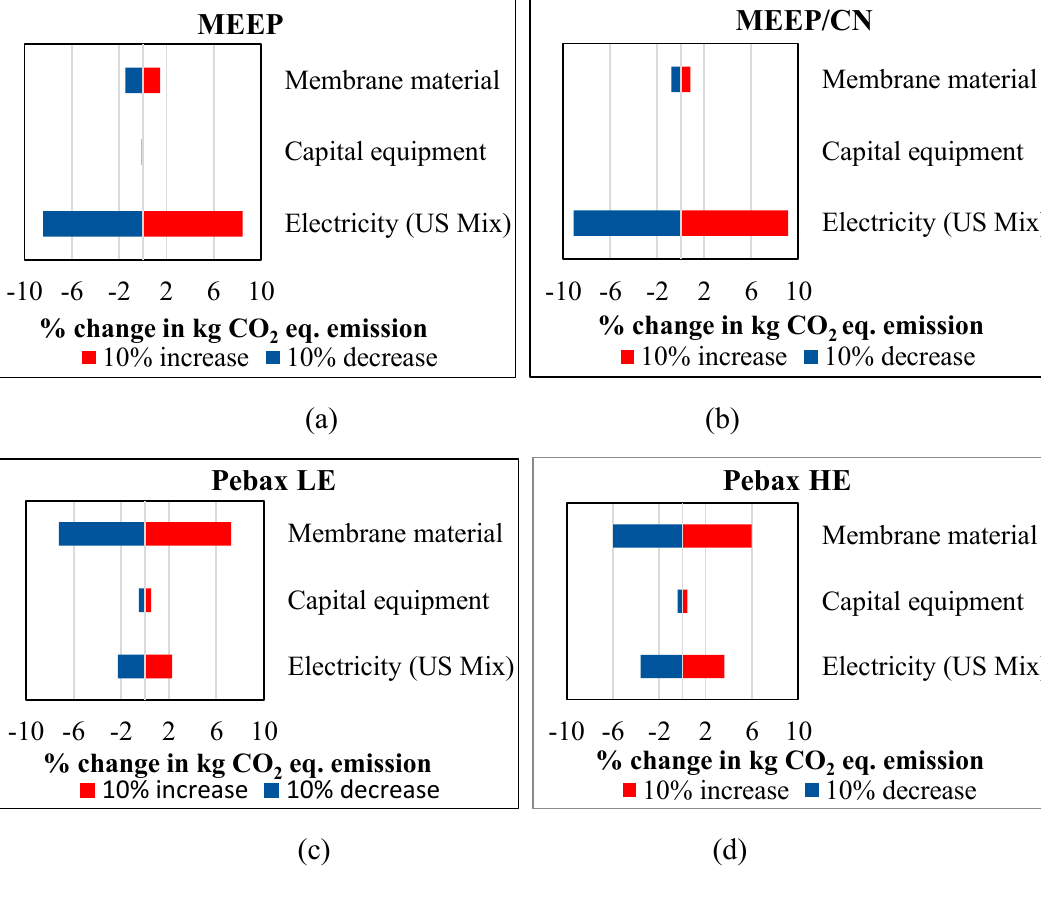
Figure 7. Sensitivity analysis of GWP by increasing and decreasing by 10% membrane material, capital equipment, and electricity requirements of ( a ) MEEP, ( b ) MEEP/CN, ( c ) Pebax LE, ( d ) Pebax HE, and (e) Pebax ZIF-8 membrane processes. 4. Conclusions A comprehensive LCA of gas separation processes was performed using the GREET database by developing a Microsoft Excel-based model. Multiple scenarios of the CO 2 /N 2 separation using Pebax-based membranes were compared with MEEP-based INL mem-